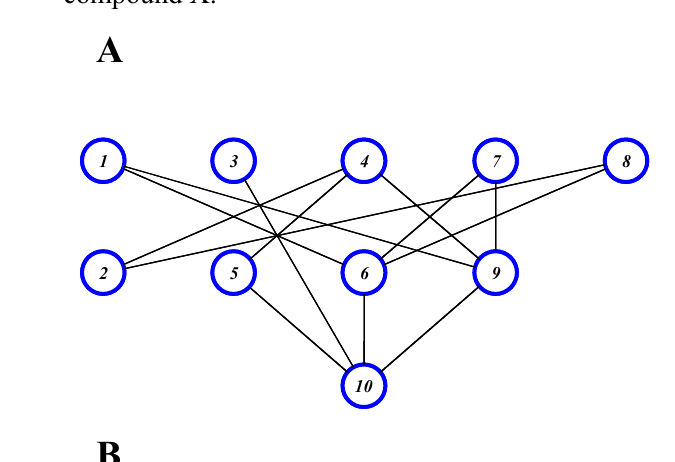
Figure 1. Illustrative Hasse diagram of A: 10 compounds using three descriptors and B: the same 10 compounds plus one new compound